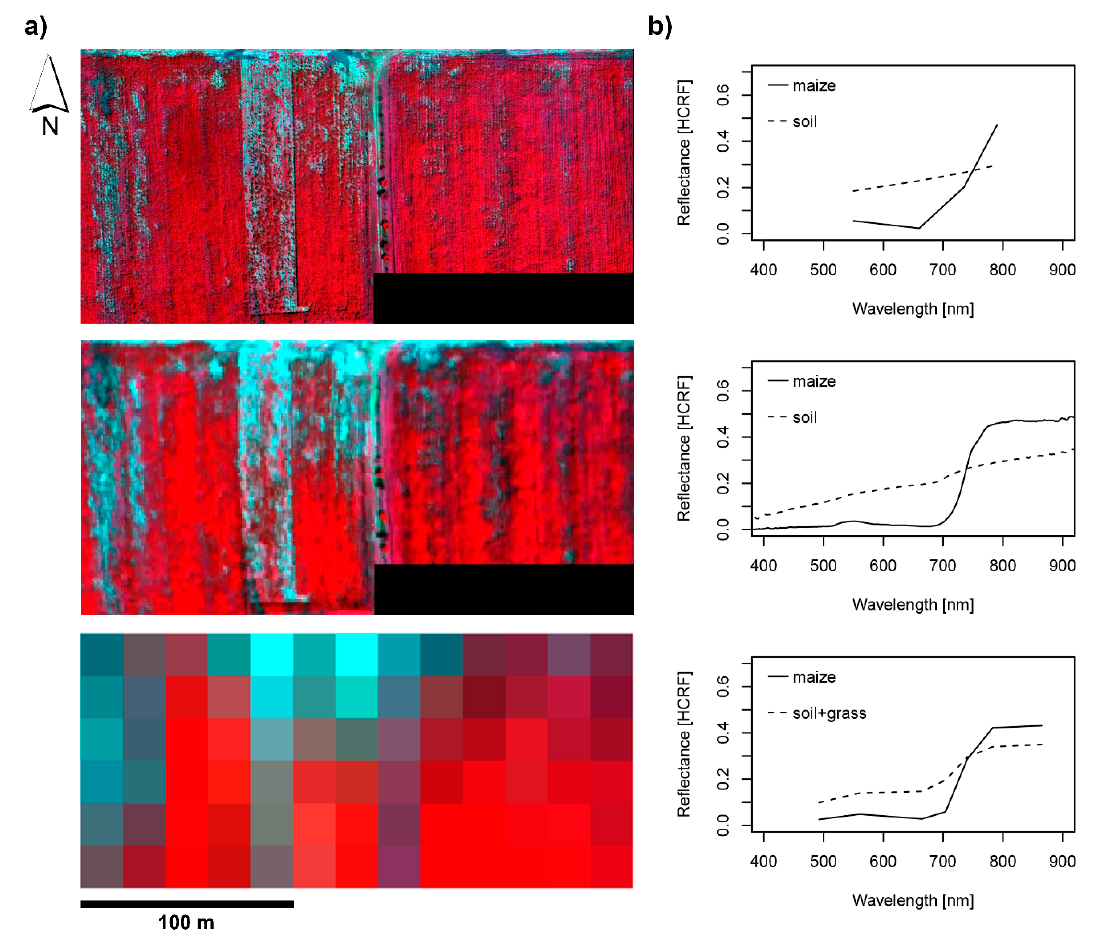
Figure 5. False-colour infrared representations ( a ) and representative hemispherical-conical reflectance factors (HCRF) spectra ( b ) of the Sequoia (top), HyPlant (middle) and S2 (bottom) surface reflectance products over the maize field study site (no pure soil pixel for S2). The subsets shown are the